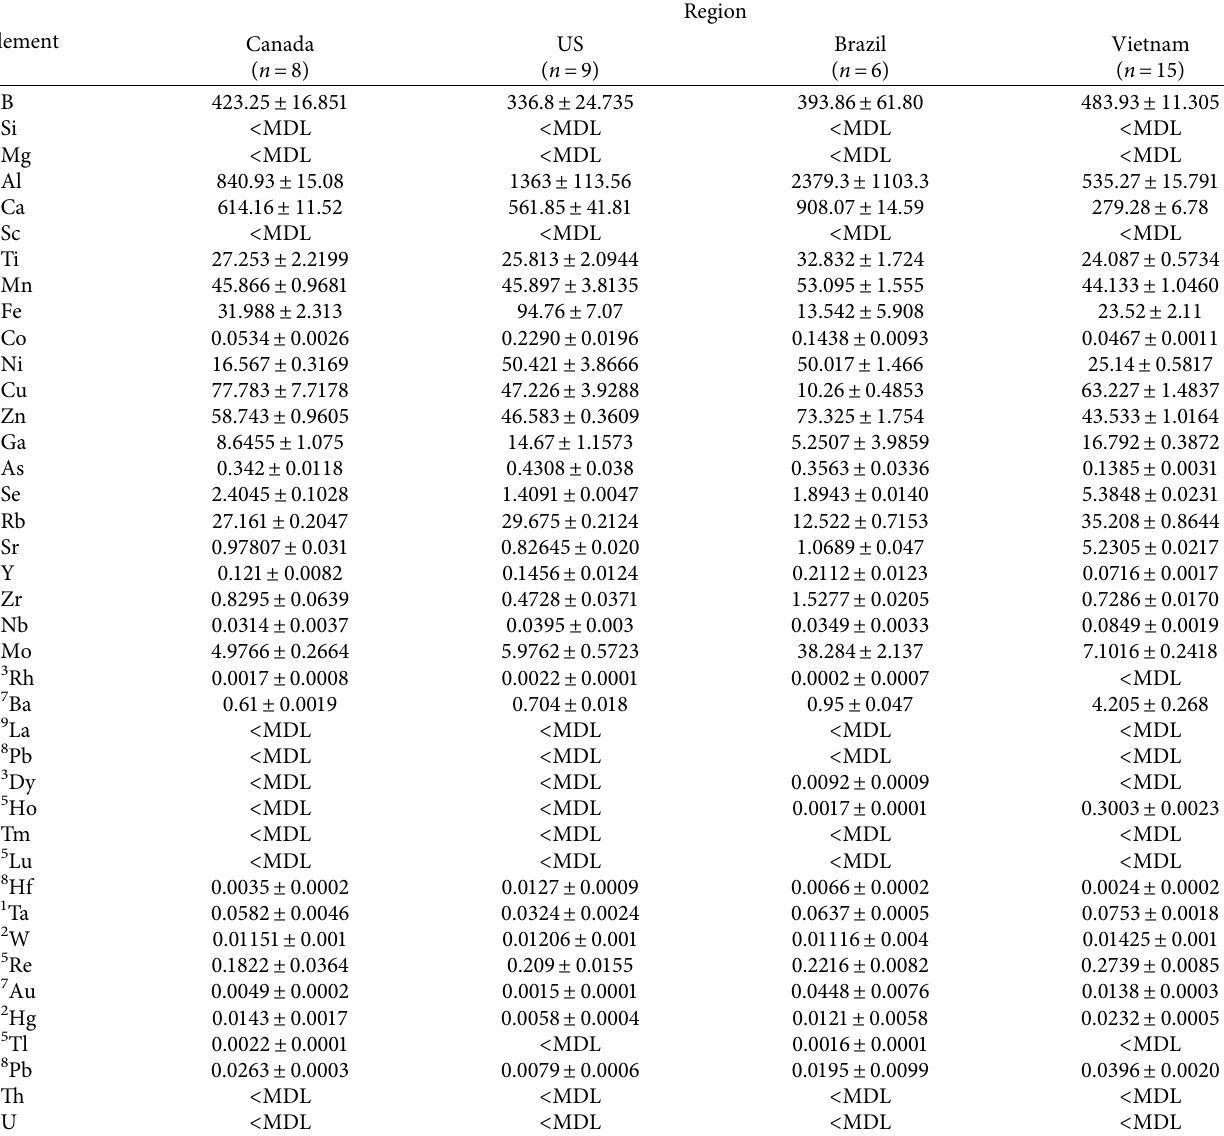
Table 2: Contents ( µ g/g, fresh weight base) of the 40 elements in soybean from 4 countries.